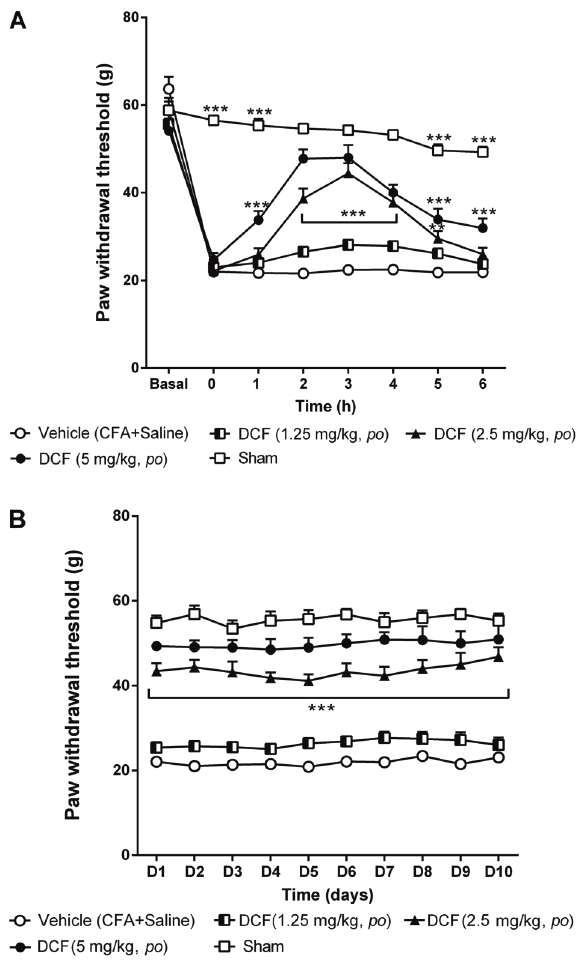
Figure 3. Effect of acute ( A ) and chronic ( B ) administration of diclofenac (DCF). Each point represents the mean ± SEM of the paw withdrawal threshold in female Wistar rats (n=6 – 8) with mechanical hyperalgesia induced by Freund ’ s complete adjuvant (CFA) (50 m L/paw) injection ( ipl ) subjected to the Randall Selitto test. **P o 0.01 and ***P o 0.001 compared to vehicle group (two-way ANOVA, Bonferroni